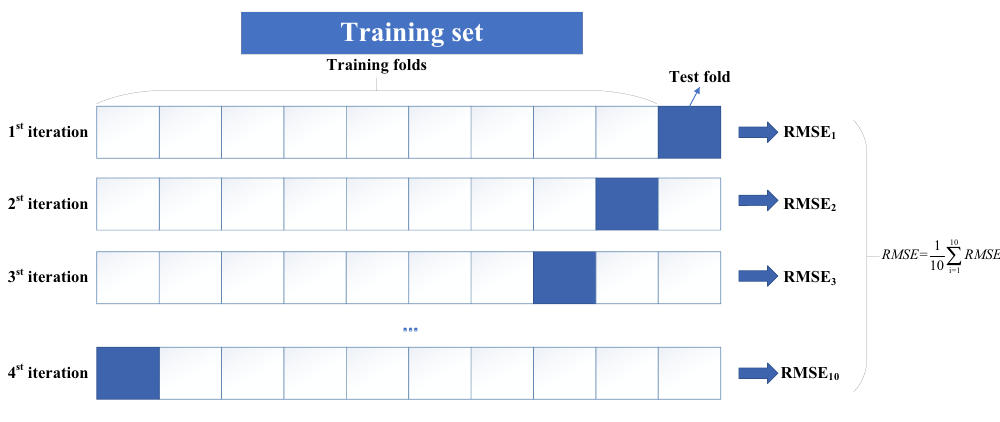
Figure 13. K-fold